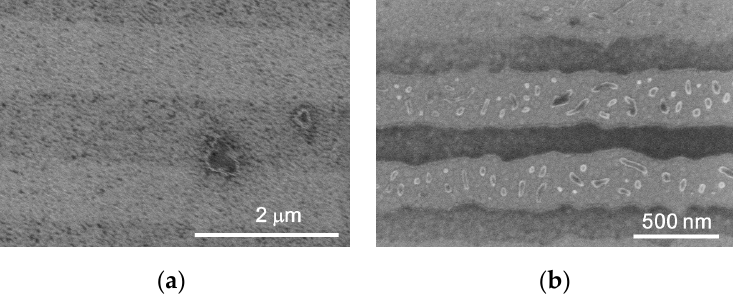
Figure 4. SEM micrographs of PMMA etched lamellar PS- b -PMMA block copolymer on Au deposited silicon substrates pre-coated with SAM at the annealing temperature of ( a ) 150 °C and ( b ) 250 °C, respectively.